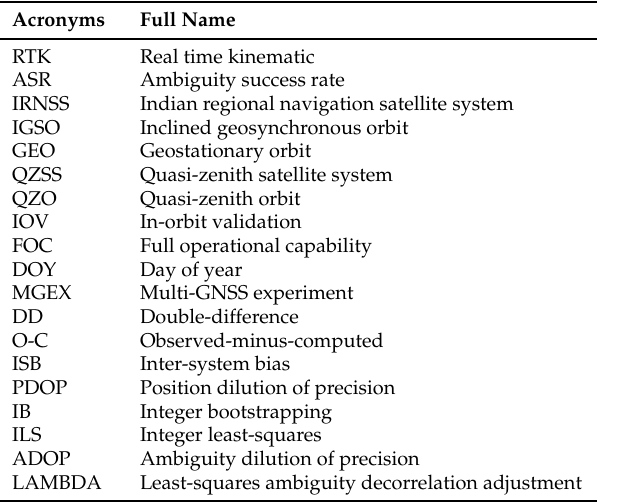
Table A2. Table of